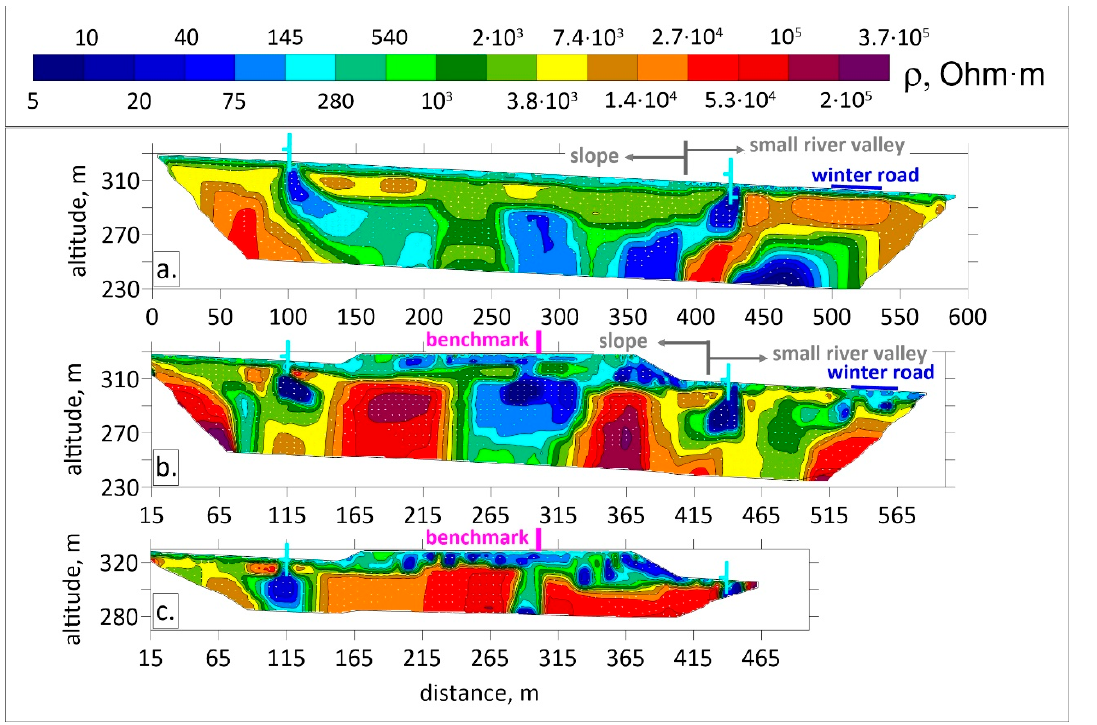
Figure 6. Inverted resistivity section (Ohm ⋅ m) along profiles 2 ( a ) and 3 ( b , c ). Pole–dipole ( a , b ) and dipole–dipole ( c ) arrays. dipole–dipole ( c )